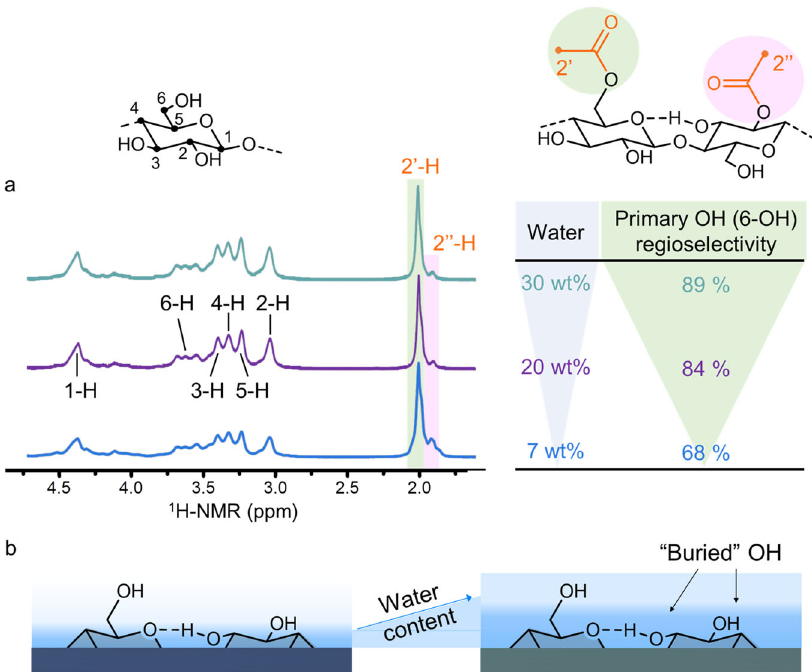
Fig. 3 Water-mediated control of regioselectivity. Diffusion-edited 1 H-NMR spectra ( a ) identi fi ed that increasing water allowed for more control over the acetylation regioselectivity. The primary hydroxyl group (6-OH) was modi fi ed with up to 89% selectivity in the presence of 30 wt% water, unparalleled for a simple esteri fi cation. At elevated water content and higher hydration, the secondary hydroxyl groups are ‘ buried' rendering them chemically less accessible ( b